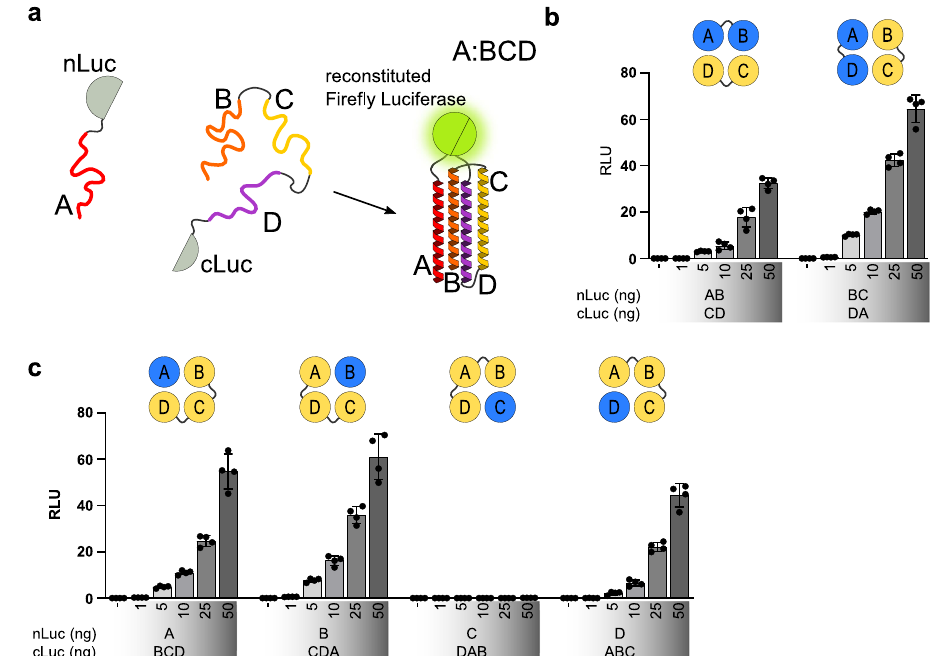
Fig. 2 | Design and characterization of 4HB dimerization domains in HEK293T cells. a Schematic of the split fi re fl y luciferase system explained on A:BCDdimerizationof4HB.4HBissplitintotwoparts — peptideAandpeptidesBCD — and fused with the N-terminal (nLuc) and C-terminal (cLuc) domains of fi re fl y luciferase, respectively. Peptides are unstructured until in close enough proximity for the formation of a 4HB, where each peptide structures into an alpha helix. The